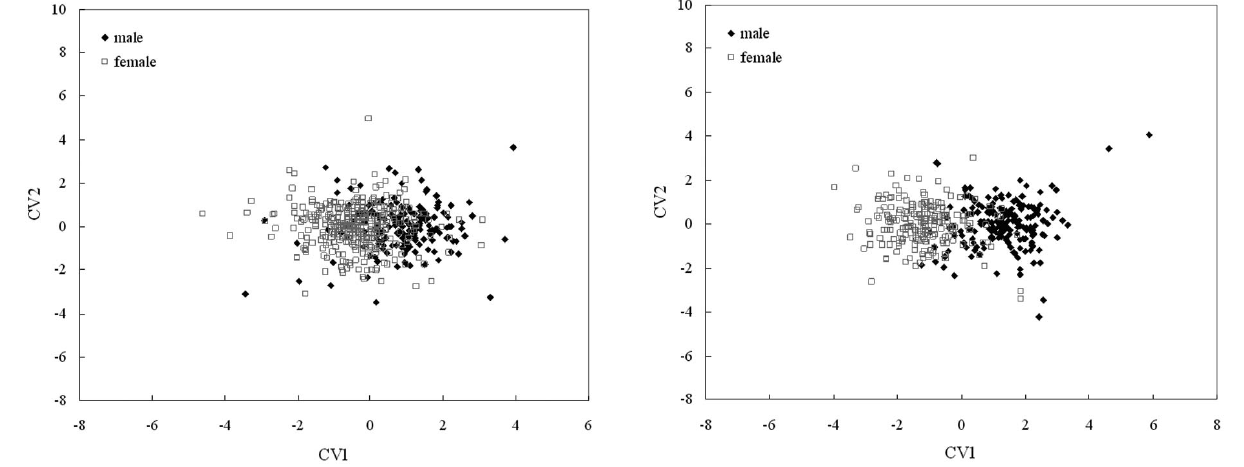
F Ig . 6. – Plot of canonical variables (CV1 vs. CV2) for male and female beak morphological variables of I. argentinus